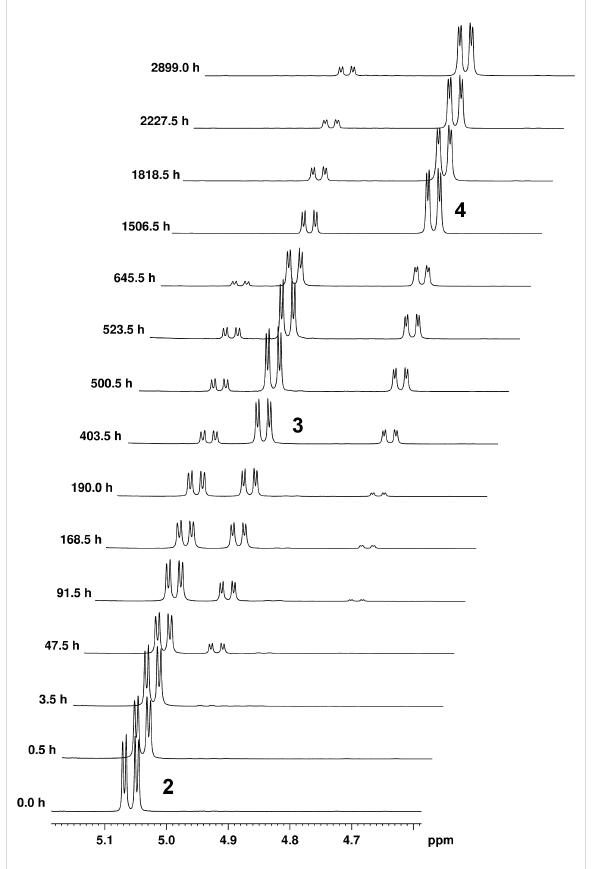
Figure 2: Time-dependent 1 H NMR spectra of 2 , 3 and 4 (13-H multi- plets region). The experiments were performed on 0.1 M chloroform- d 1 solution of 2 at 25 °C. Spectra were recorded at appropriate time inter- vals after the initial addition of 10 μ L of 1 M